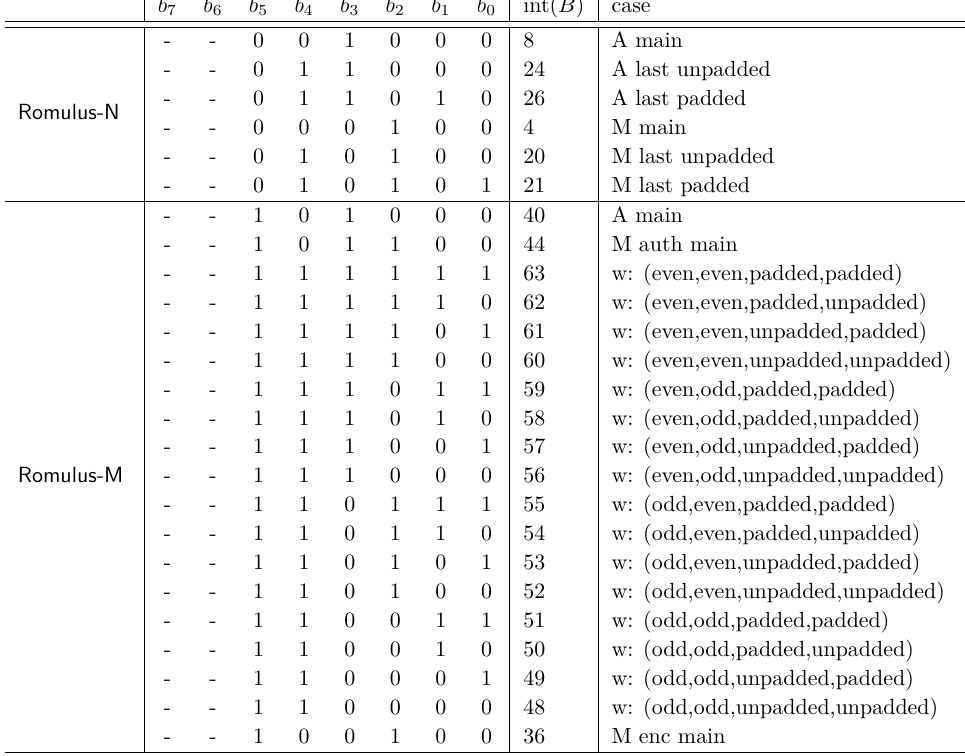
Figure 16: Domain separation when using the tweakable block cipher Table 6: Domain separation byte B of Romulus . Bits b 7 and b 6 are to be set to the appropriate value according to the parameter